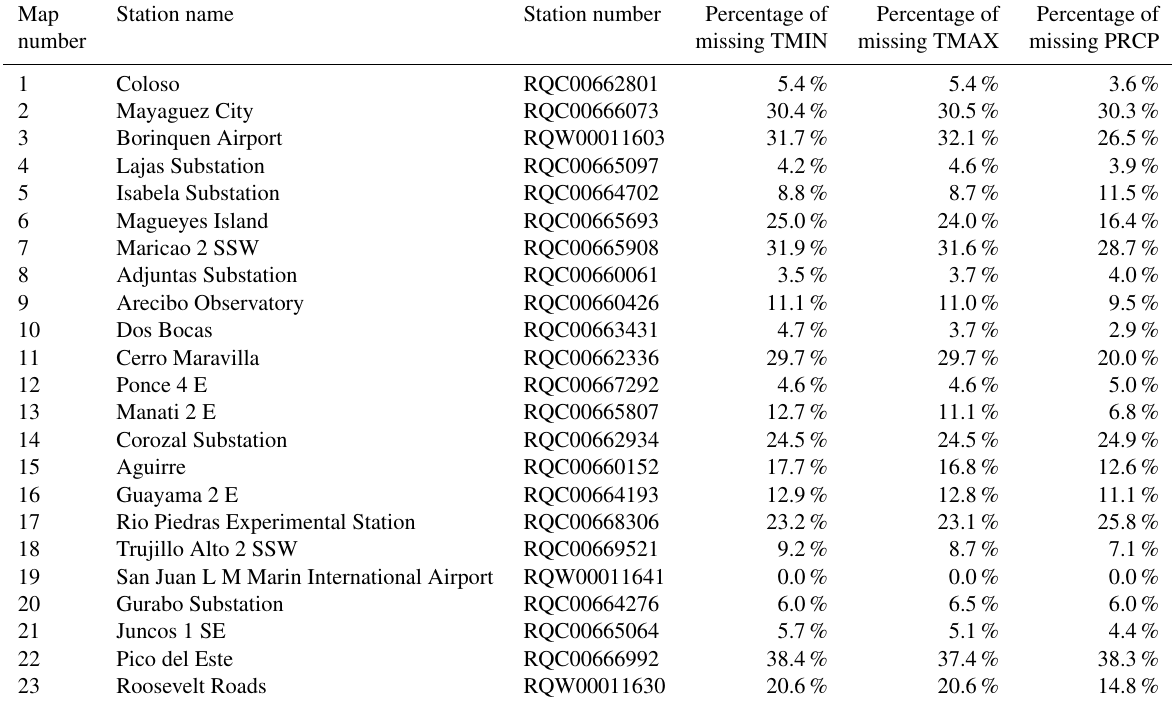
Table 1. The 23 GHCN weather stations of interest in Puerto Rico along with the proportion of missing observations (after cleaning –